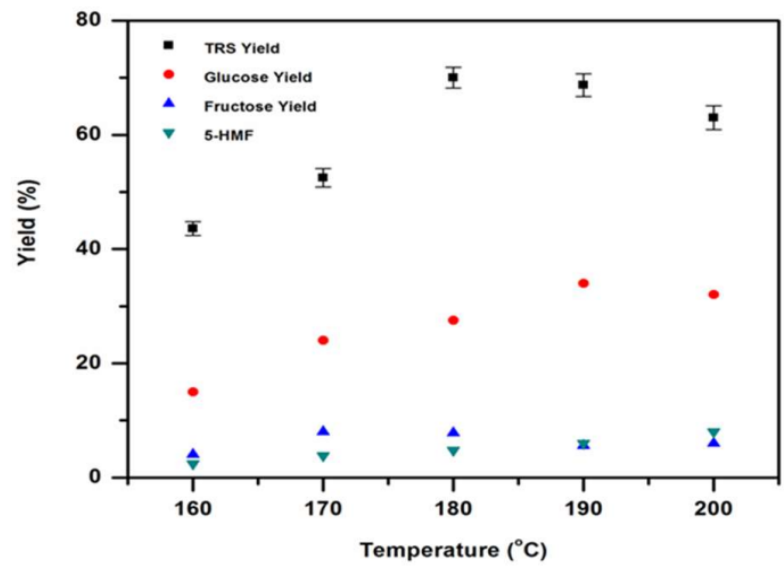
Figure 4. Effect of hydrolysis temperature on TRS yield (catalyst-to-substrate ratio of 2:1 ( w / w ) and 180 min of reaction time) .